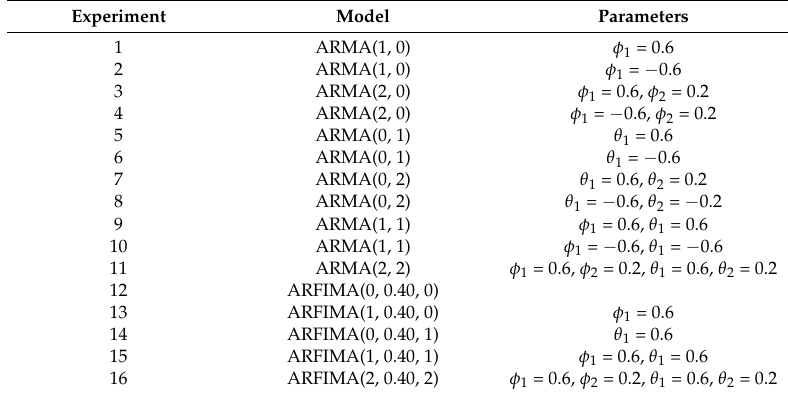
Table 5. Simulation experiments, their respective models and their defined parameters. See Section 2.1.1 for the definitions of the parameters.